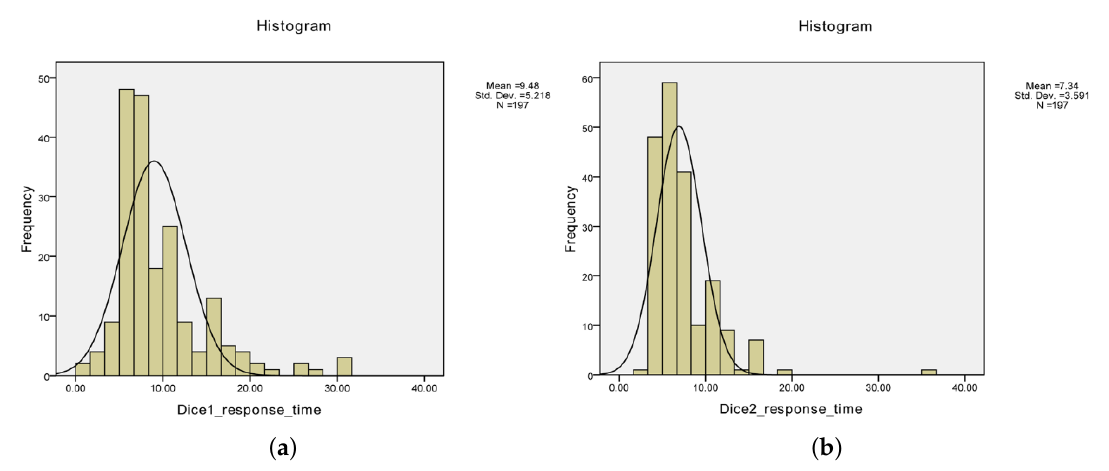
Figure 3. Distribution of the CAPTCHA solution time for: ( a ) Dice 1; and ( b ) Dice